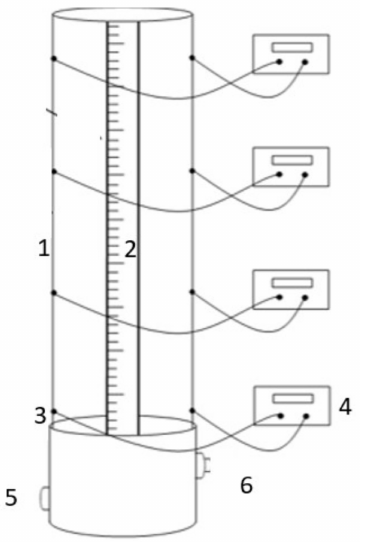
Figure 4. Schematic diagram of the homemade dynamic foam analyser, where the first ohm-meter is positioned close to the bottom and the other electrodes are positioned at 10 cm, 17.5 cm, and 32.5 cm above this point. 1. is the acrylic column, 2. scale, 3. electrodes which are located on each side of the column to allow the resistance and hence the conductivity across the foam to measured, 4. ohmmeter used to obtain the resistance across the foam, 5. gas inlet, and 6. liquid outlet which is plugged during the experiment and is used to allow the easy drainage of the liquid out of the